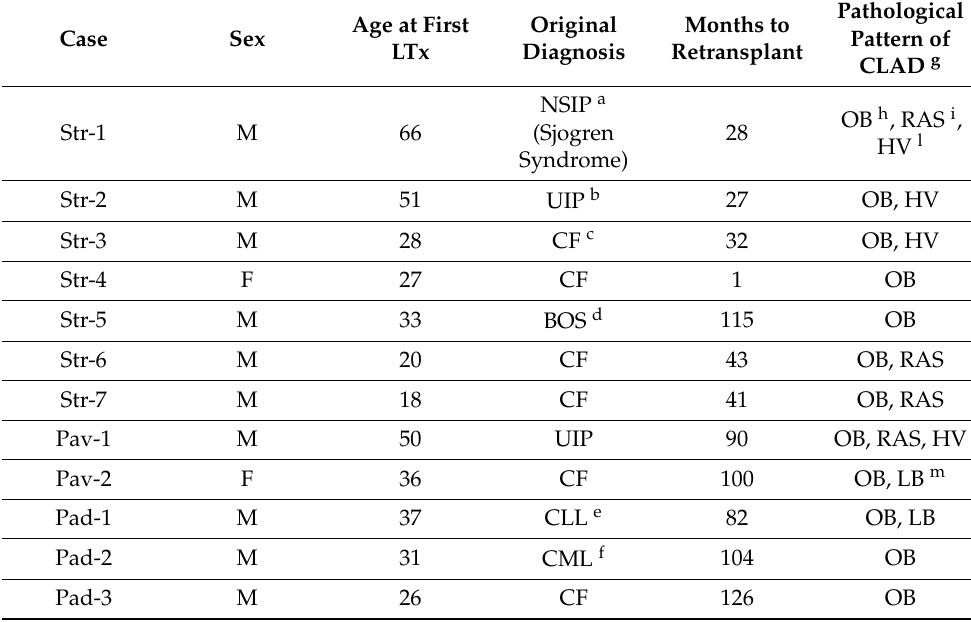
Table 1. Clinical data of studied